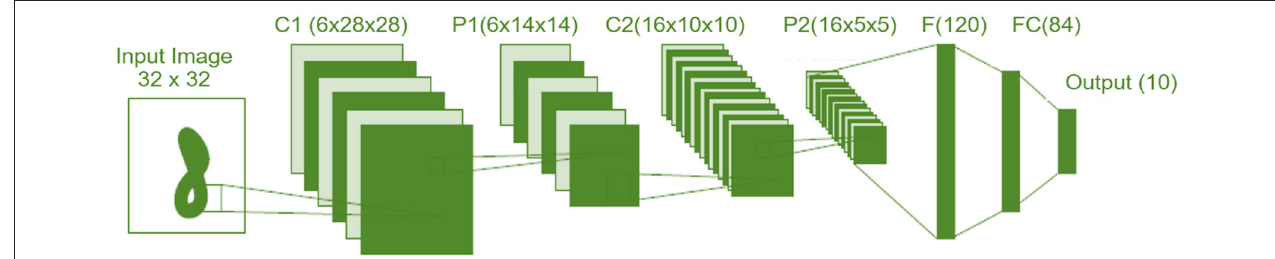
FIGURE 4 | An example of deep convolutional neural network: LeNet-5 (Kim, 2017).